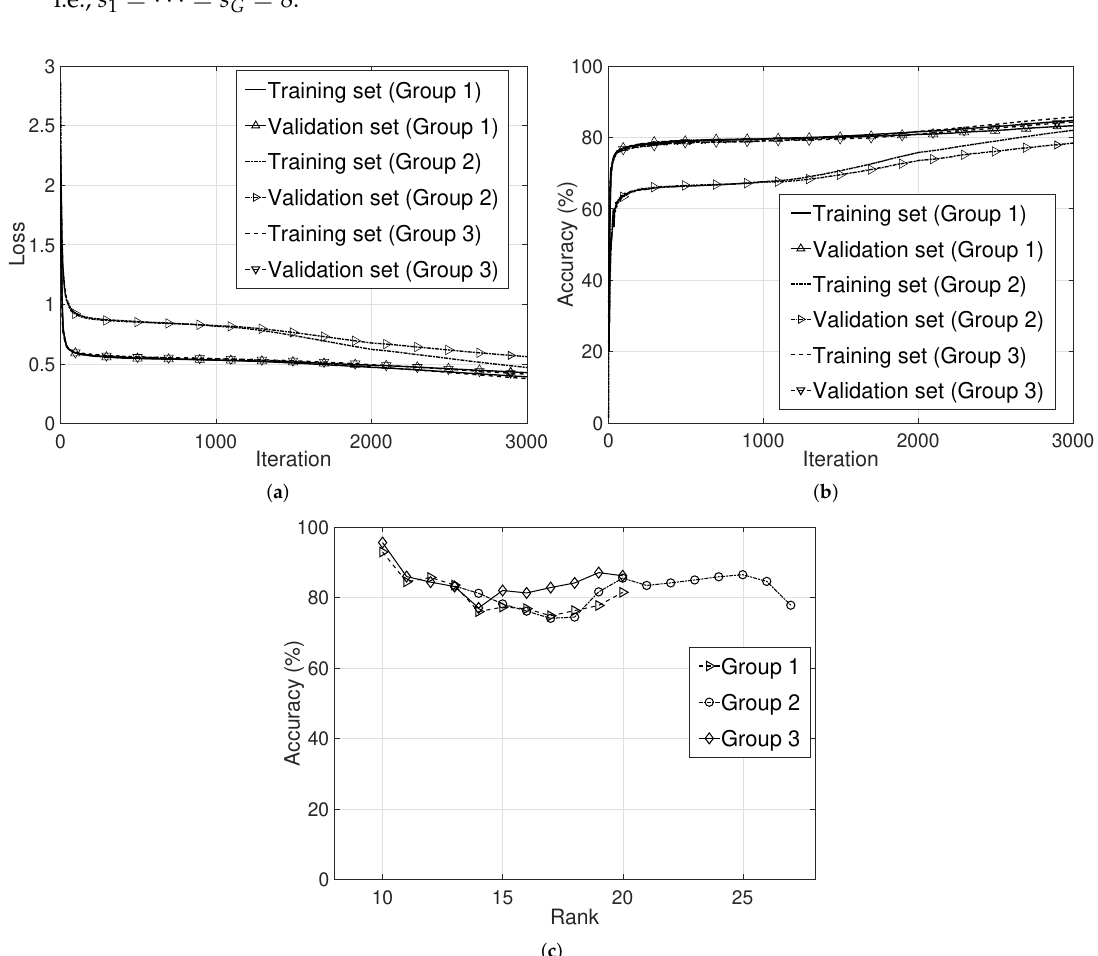
Figure 5. Training state and performance of the proposed DNN model. ( a ) the cross entropy loss with respect to the number of iterations; ( b ) the accuracy with respect to the number of iterations; ( c ) the accuracy with respect to the number of